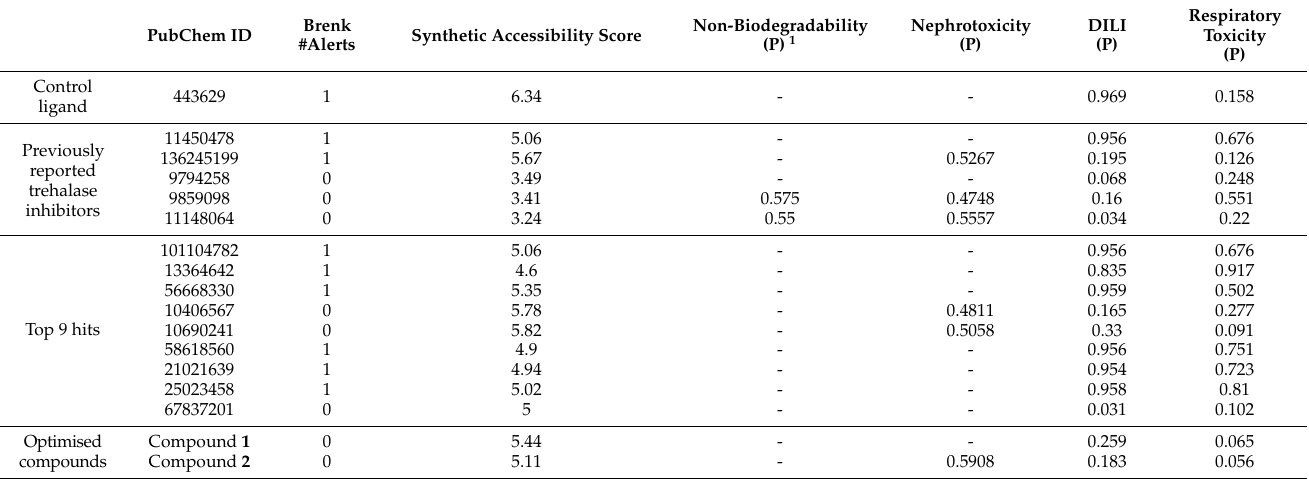
Table 4. ADMET prediction of control ligand, previously reported trehalase inhibitors, top 9 hits, and optimised compounds.